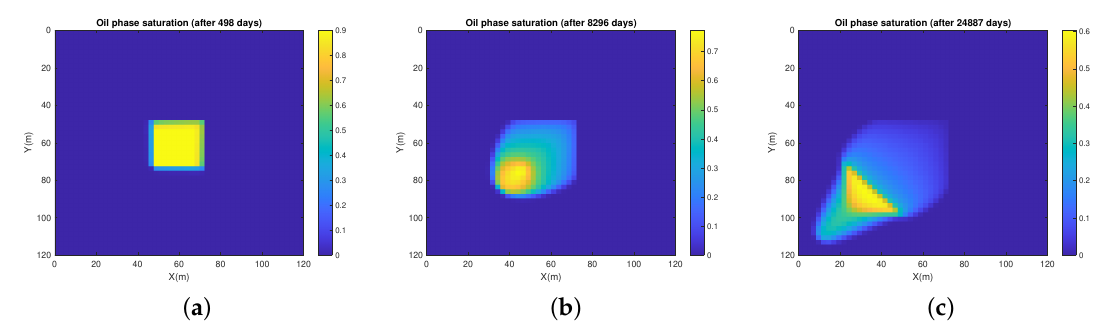
Figure 12. Oil saturation at different time for Example 3: ( a ) Oil saturation (after 498 days). ( b ) Oil saturation (after 8296 days). ( c ) Oil saturation (after 24,887 days).